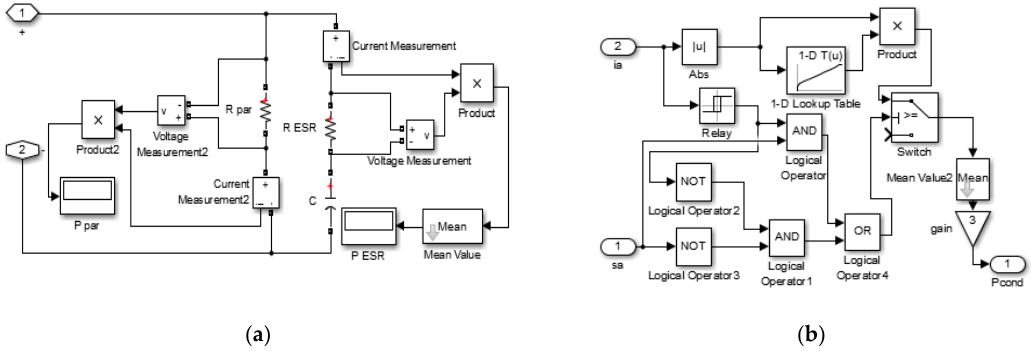
Figure 7. ( a ) Model of DC-link; ( b ) IGBT conduction losses calculation.